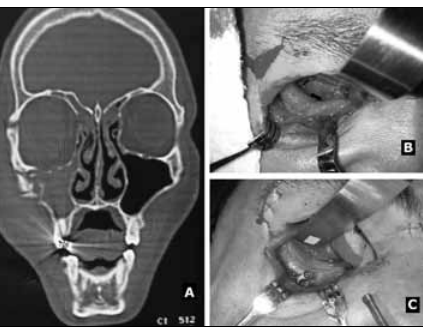
Figure 1. Patient one: A: Preoperative computed tomography of the facial bones showing signs of fractures on the floor of the orbit to the right, on the zygomaticomaxillary crest, and on the ipsilateral zygomaticofrontal suture area; B: Defect on the floor of the right orbit; C: Reconstructed floor using castor seed polymer